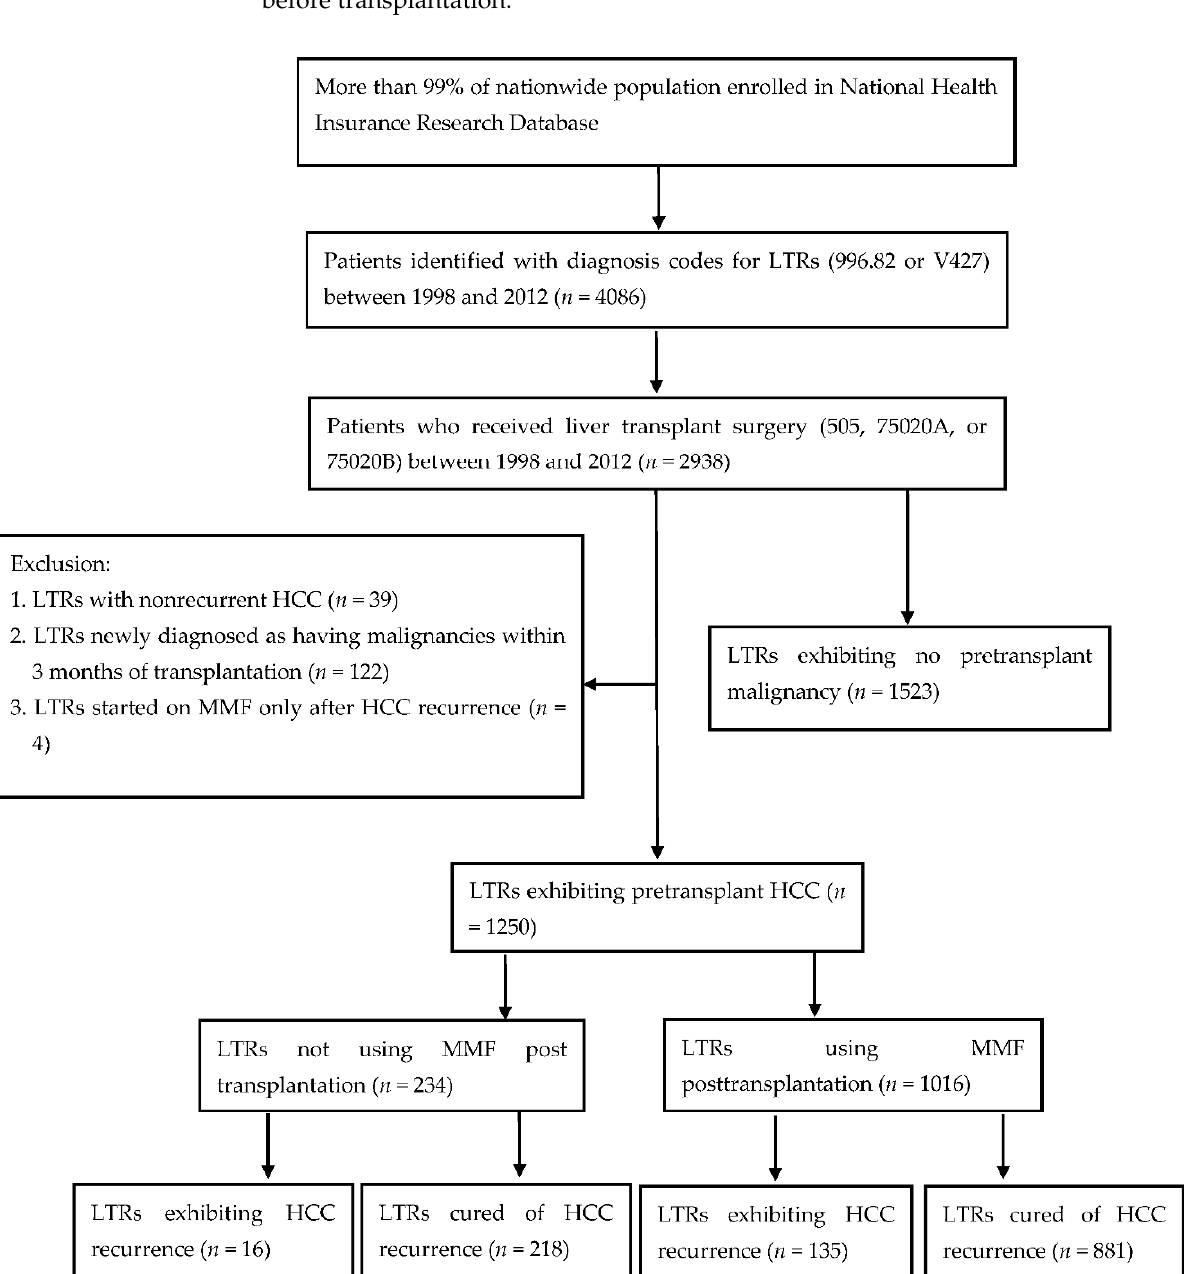
Figure 1. Flowchart of study selection. LTRs, liver transplant recipients; HCC, hepatocellular carcinoma; MMF, mycophenolate mofetil.